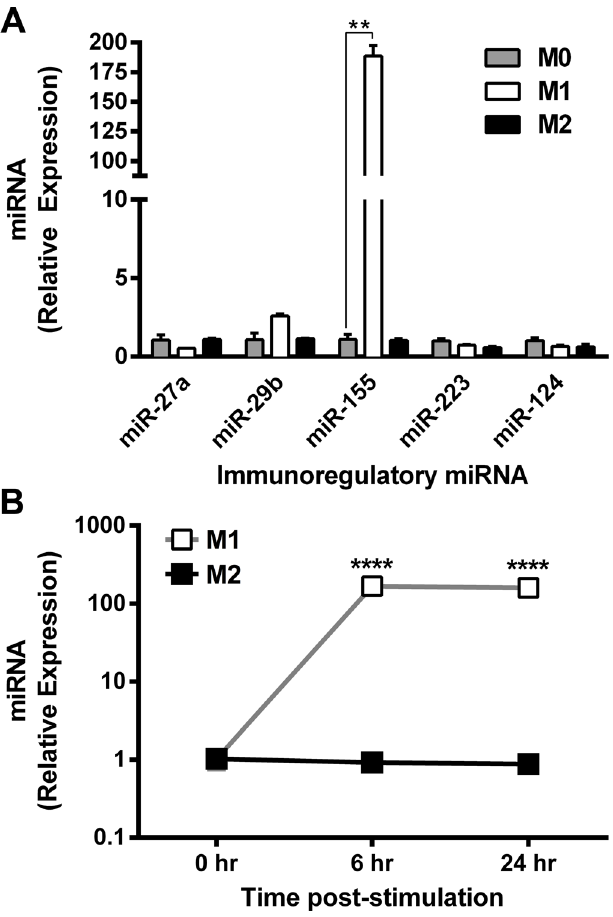
Fig 1. miR-155 is associated with the classically activated macrophage phenotype. Expression of miRNAs was determined by Taqman Real-Time PCR and expressed as mean relative expression (+ SEM) in (A) macrophages stimulated in vitro for 24 hours in M0, M1, and M2 (n = 3) conditions; expression relative to M0 condition; Post-hoc ANOVA, ** p < 0.005. (B) M1 and M2 macrophages activated in vitro over a 48 hour period; expression relative to 0 hour pre-stimulation time-point. Unpaired t-test, *** p < 0.001. Results reproduced in two independent